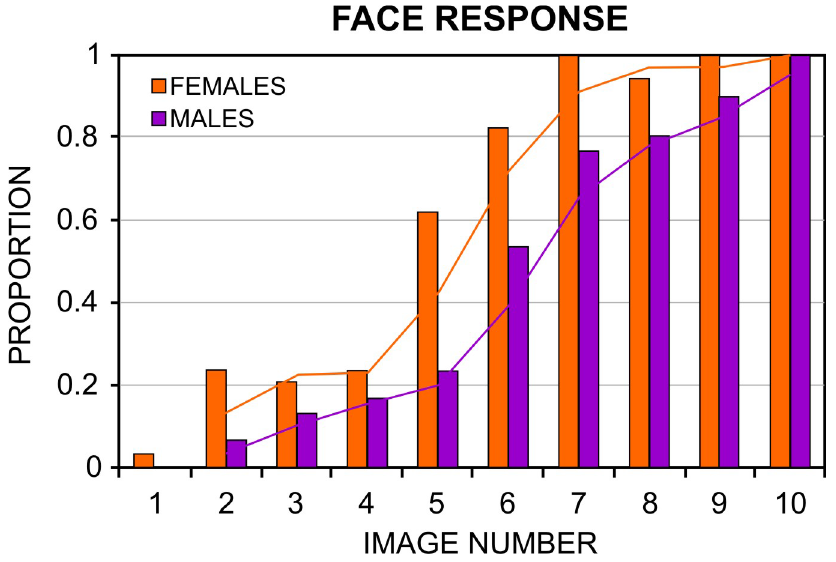
Fig 4. Proportion of face responses to each image in the Face-n-Food task for female and male participants. The image number reflects its recognizability as a face (1 — the least recognizable, 10 — the most recognizable). Fitted trend curves represent moving average of face response proportion across the images. Females not only earlier report seeing a face and give on overall more face responses, but also faster reach a ceiling level of